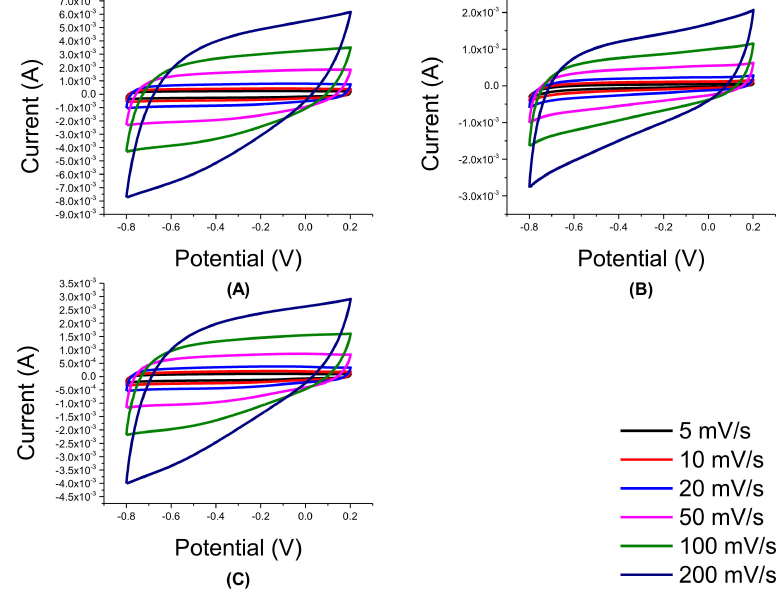
Figure 5. CV of GO/TNT: ( A ) 3:1, ( B ) 1:1, and ( C )